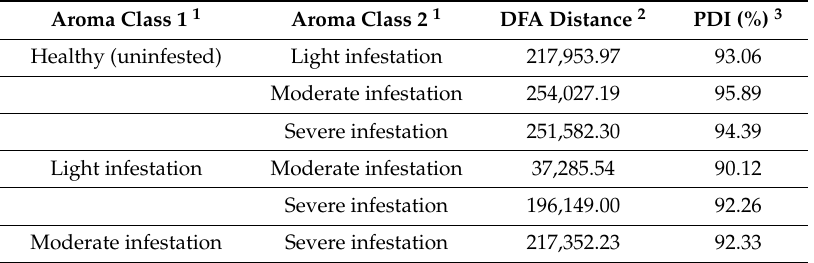
Table 2. Chemical relatedness between electronic-nose VOC-profiles of green ash tree core headspace volatiles analyzed by 3-d DFA with pattern discrimination